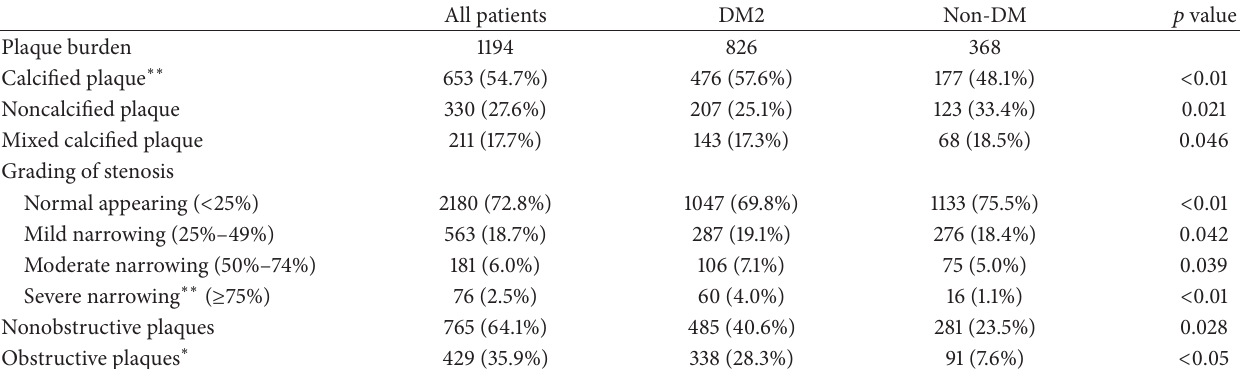
Table 2: Comparison of plaque burden and grading of stenosis between diabetic and nondiabetic patients.